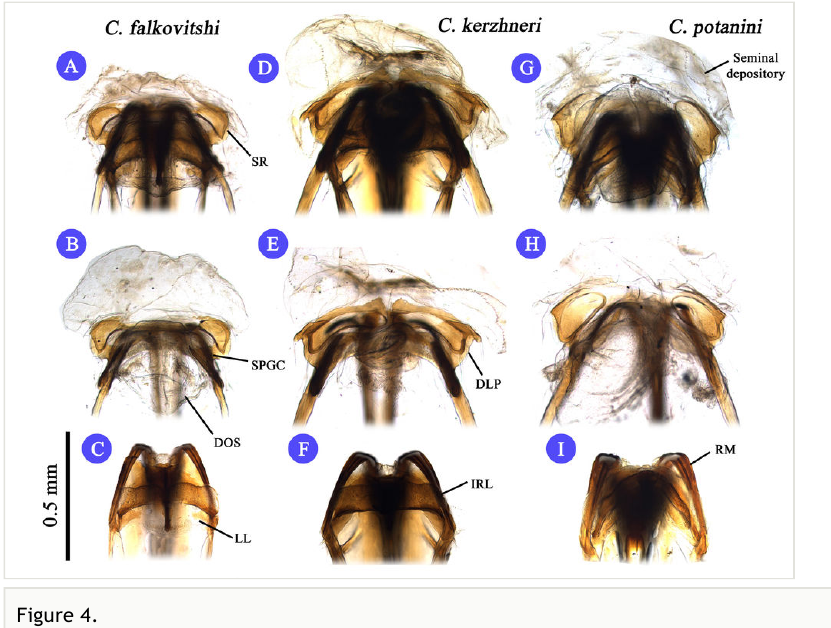
Figure 4. Female genital structure of Korean Castanopsides species (A–C: C. falkovitshi ; D–F: C. kerzhneri ; G–I: C. potanini ). A, D, G: Bursa copulatrix (Before dissect posterior wall); B, E, H: Bursa copulatrix; C, F,I: Posterior